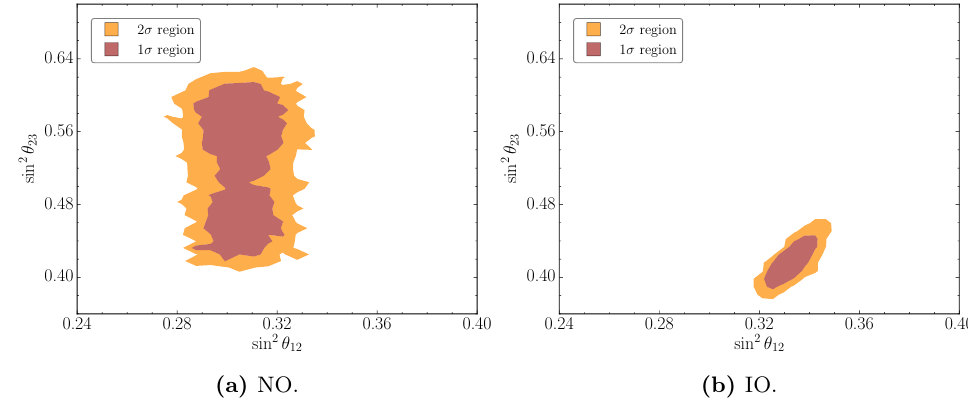
from the di(cid:11)erent parameters and observables in NO min q (cid:31) 2 . min ;i